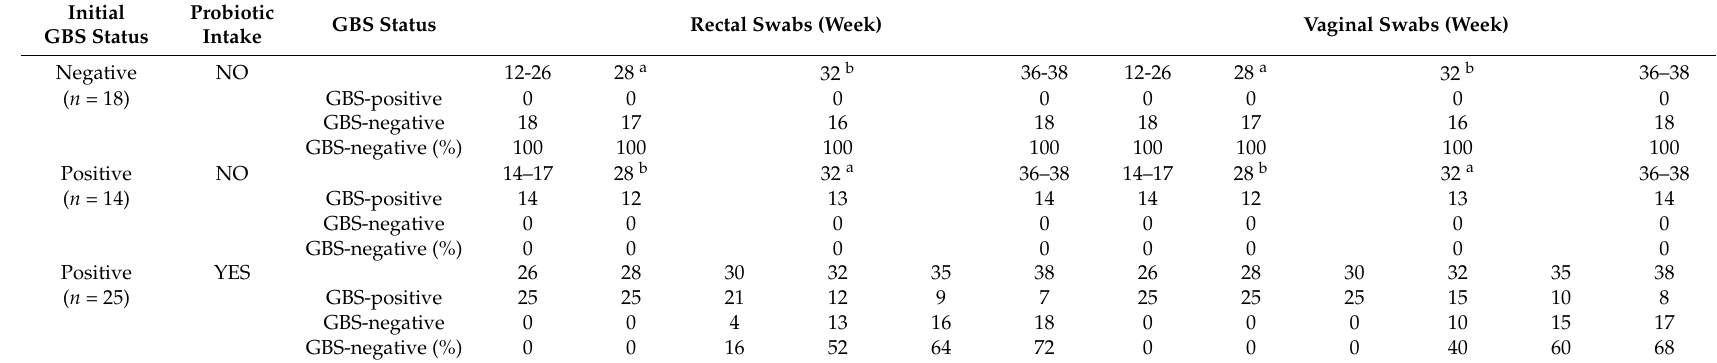
Table 6. The qualitative assessment (Group B Streptococci (GBS)-positive/GBS-negative) of Streptococcus agalactiae in rectal and vaginal swabs of participants ( N = 57). Initial Probiotic GBS Status Rectal Swabs (Week) Vaginal Swabs (Week) GBS Status Intake